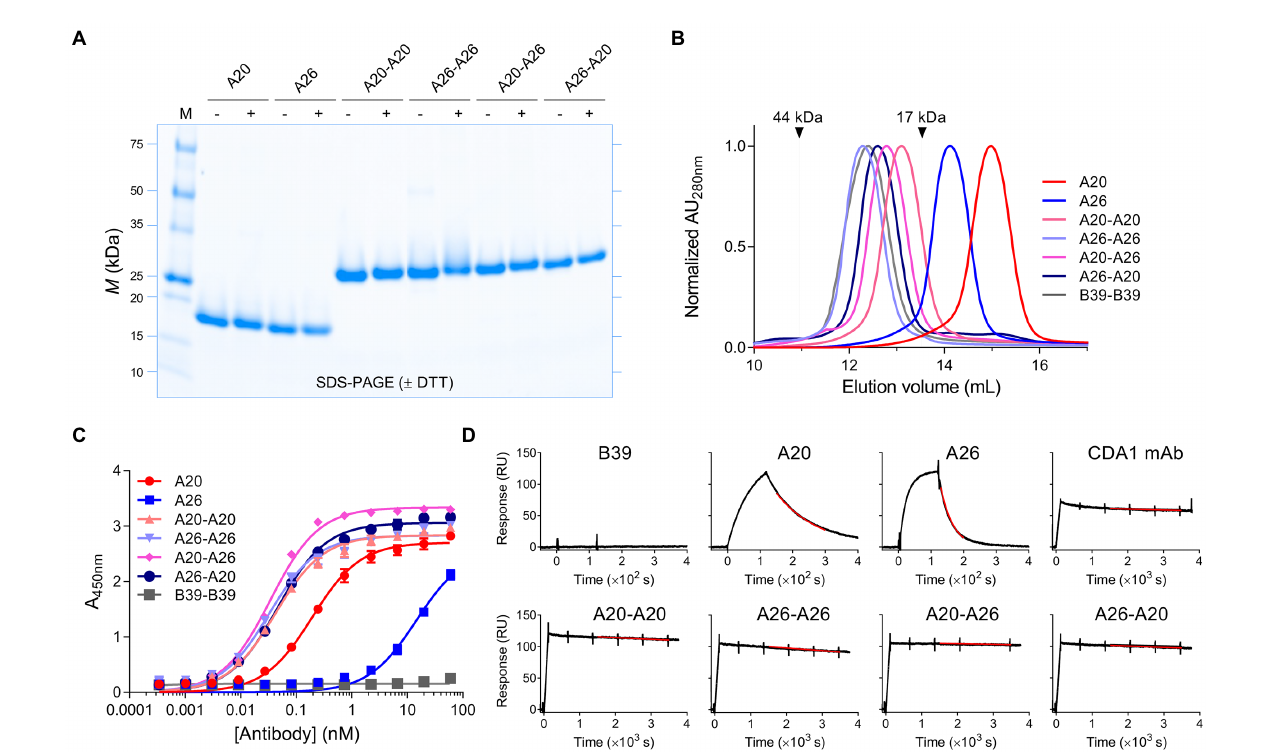
FIGURE 2 Biophysical characterization of anti-TcdA V H H constructs. (A) Representative SDS-PAGE analysis of V H H monomers and dimers is shown under reducing (+DTT [dithiothreitol]) and non-reducing ( − DTT) conditions. M, protein molecular mass standards AU, absorbance unit. (B) SEC analysis of the antibodies with arrows indicating the elution positions of ovalbumin (44 kDa) and myoglobulin (17 kDa) protein standards. (C) Titration of the antibodies against full- length TcdA by ELISA. B39-B39 (a dimer of the anti-TcdB V H H B39 with a (GS) 6 linker) is used as a negative control. Error bars indicate standard deviation (SD) of three technical replicates. (D) Representative SPR sensorgrams comparing off-rate of V H Hs, V H H dimers and CDA1 mAb binding to immobilized TcdA-A2 fragment at 37 ° C with 5min or 60min dissociations. Black lines represent raw data points; red lines are fits to a separate k d 1:1 binding model. RU, resonance